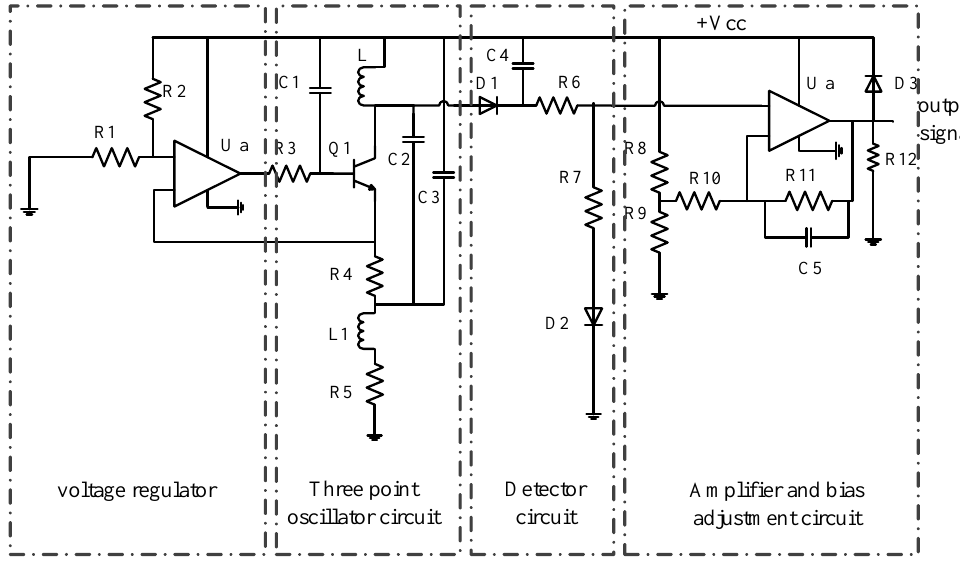
Figure 9. The CECA sensor inspection circuit.